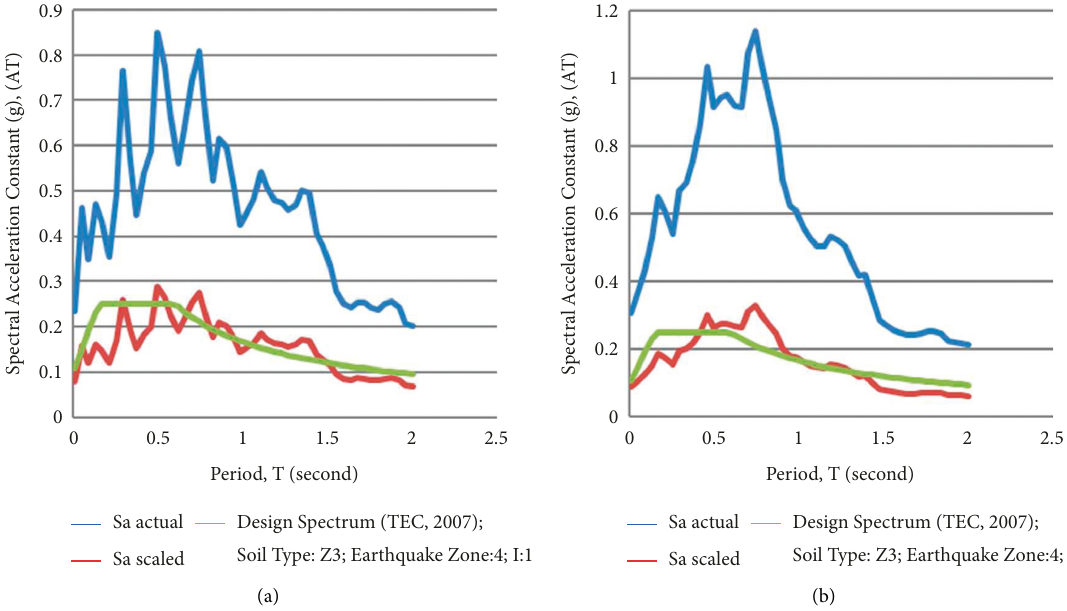
Figure 17: Evaluation of A(T) spectral acceleration constants at Aksaray station for (a) North-South (N-S) and (b) East-West (E-W) components of earthquake with epicenter at Kayseri-Kocasinan ( M L :